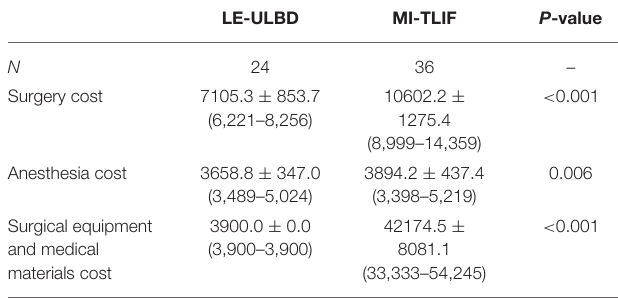
TABLE 6 | Complications of the two groups. LE-ULBD MI-TLIF P -value